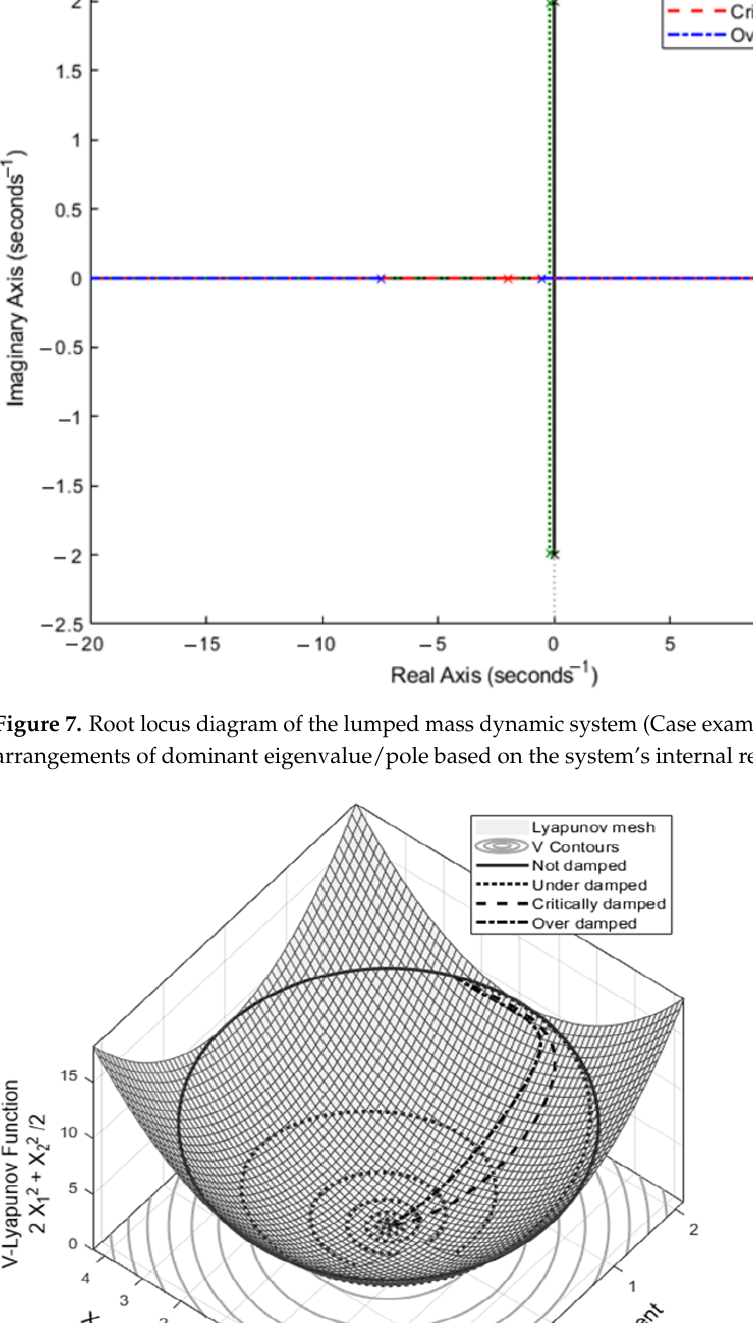
Figure 9. Lyapunov function (V) indicative of local asymptotic stability for the simple pendulum system (Case example 2) along with the system phase portraits under [ − 1.5 rad, 4] state initial values.